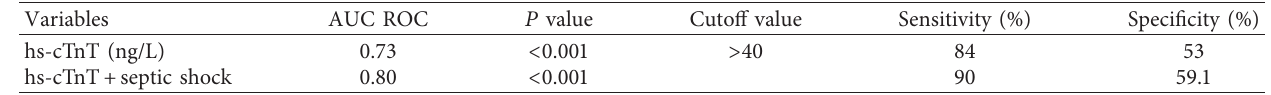
Figure 1: Receiver operating characteristic (ROC) curves for hs-cTnT and hs-cTnT combined with septic shock to predict subclinical LV systolic dysfunction. The serum hs-cTnT level had power for predicting subclinical LV systolic dysfunction as suggested by the area under the curve (AUC) of 0.73, P < Table 2: Performance of variables in predicting left ventricular systolic dysfunction.